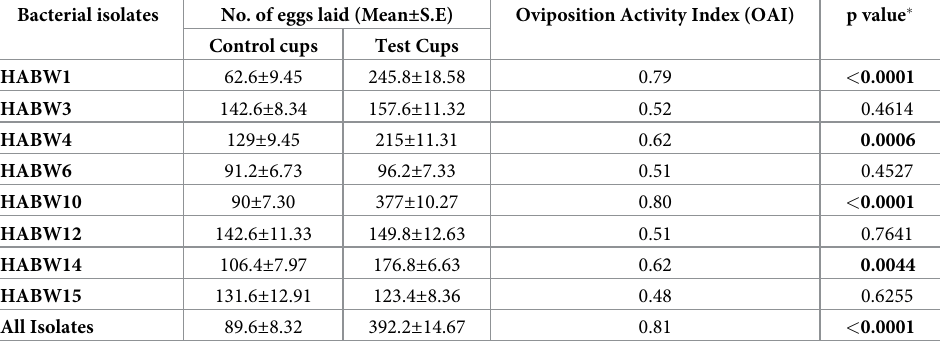
Table 8. Oviposition response of Anopheles subpictus to bacterial isolates in dual choice bioassay. Bacterial isolates No. of eggs laid (Mean ±